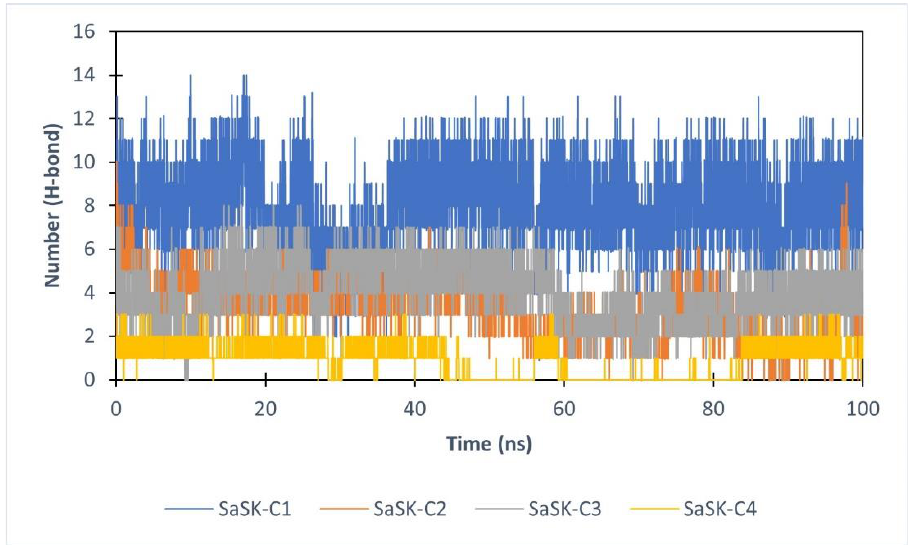
Figure 6. H-Bond analysis for each SaSK – ligand complex. Table 2. Interacting residues through the 100 ns simulation time at selected time frames.